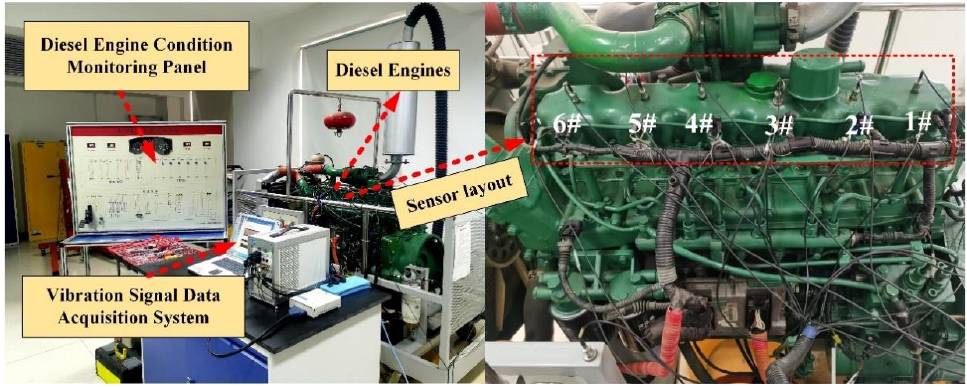
Figure 8. The test rig of the planetary gearbox.